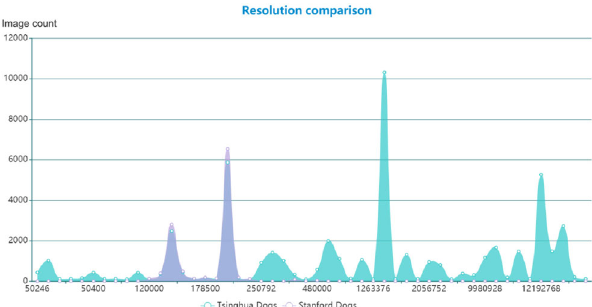
Fig. 11 Image resolutions in the Stanford Dogs and Tsinghua Dogs datasets